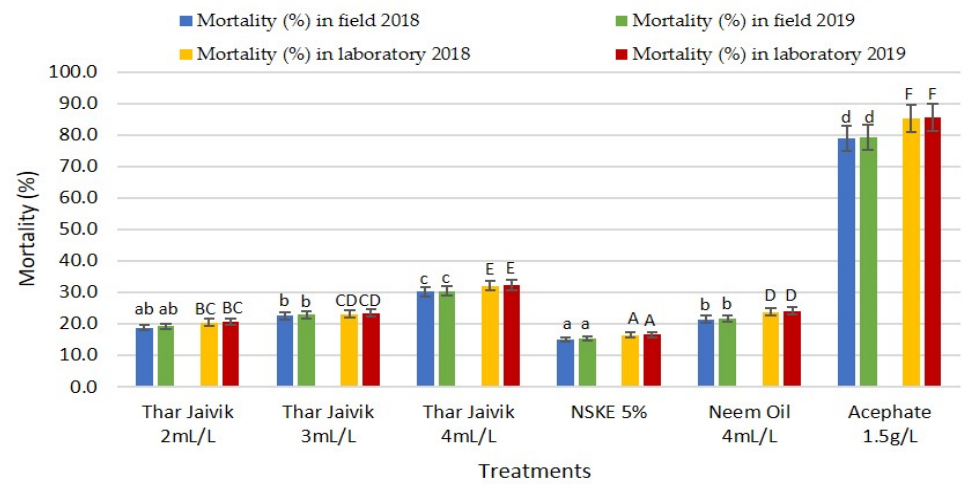
Figure 6. Efficacy of different concentrations of “Thar Jaivik 41 EC” and other biopesticides against coccinellids on citrus plant in field conditions during 2018 and 2019. NSKE: neem seed kernel extract. Different lowercase letters and uppercase letters indicate significant differences after one and three days, respectively, within field and laboratory